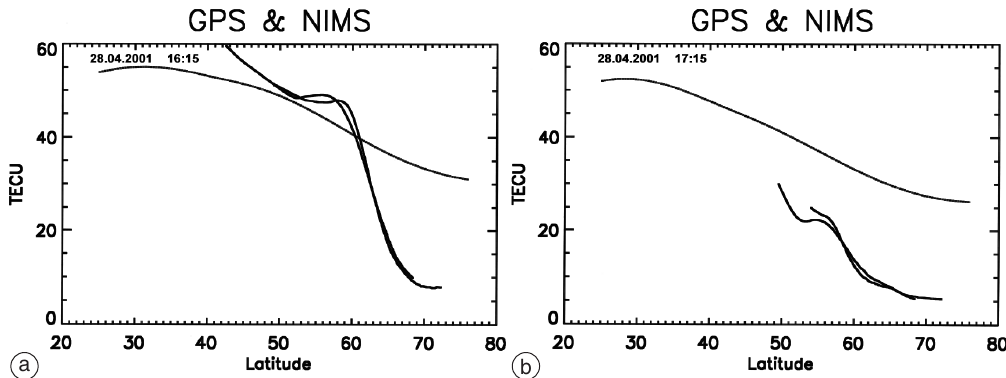
Fig. 8.7a,b. Plots of equivalent vertical TEC as a function of latitude from GPS maps (dash/dot notation) and NIMS observations at Aberystwyth and Hawick, for a satellite pass on 28 April 2001 at about (a) 16:15 UT and (b) 17:15 UT.